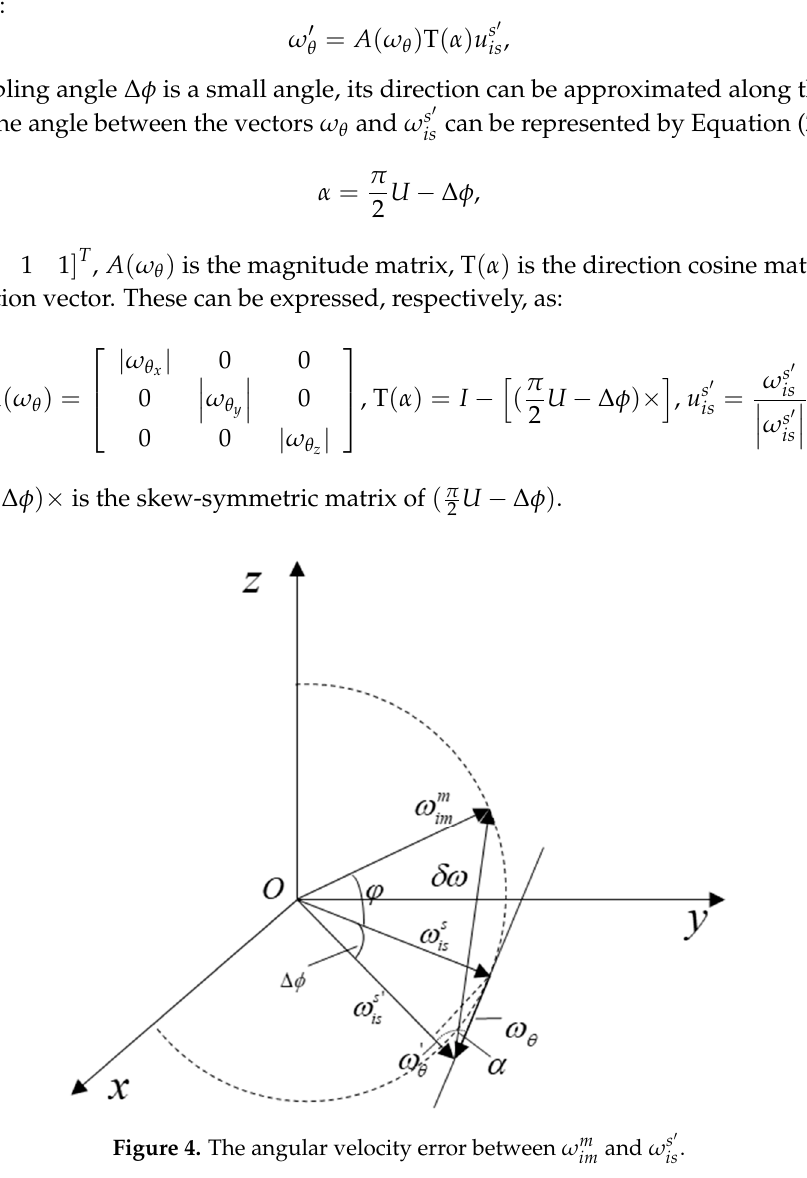
Figure 4. The angular velocity error between ω m